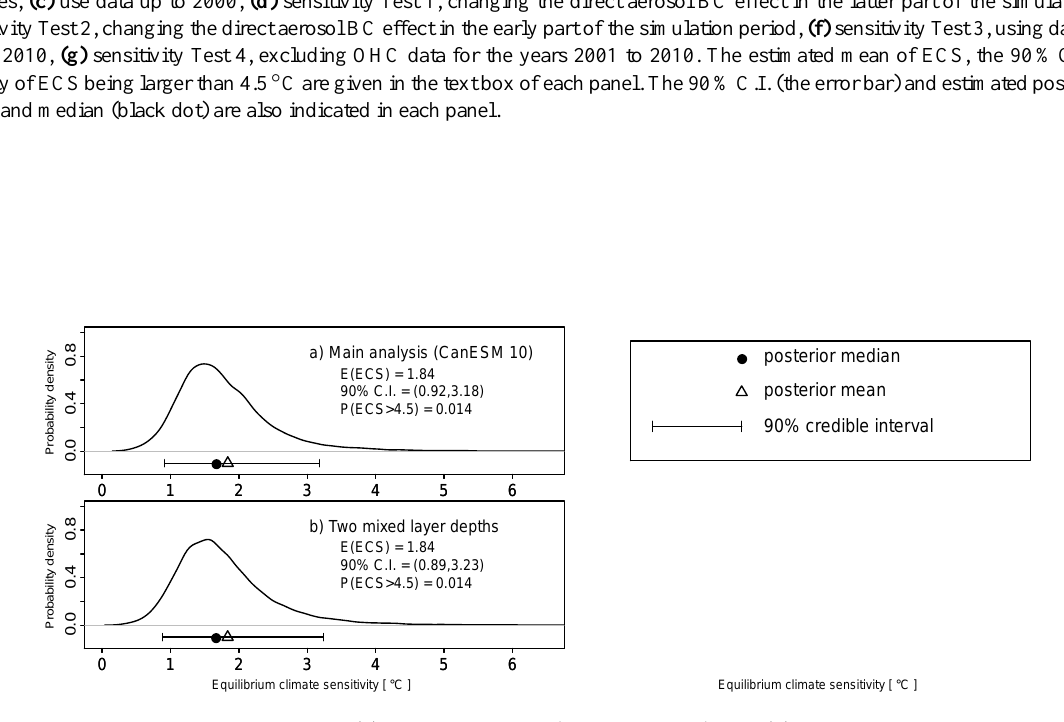
Fig. E2. Posterior distributions for the ECS for (a) the main analysis (same as Fig. 2a), and (b) the sensitivity test with two mixed layer depths, one for the Northern Hemisphere ( θ M ) and one for the Southern Hemisphere ( θ M ). The estimated mean of ECS, the 90%C.I. and NH SH the probability of ECS being larger than 4.5 ◦ C are given in the text box of each panel. The 90%C.I. (the error bar) and estimated posterior mean (triangle) and median (black dot) are also indicated in each